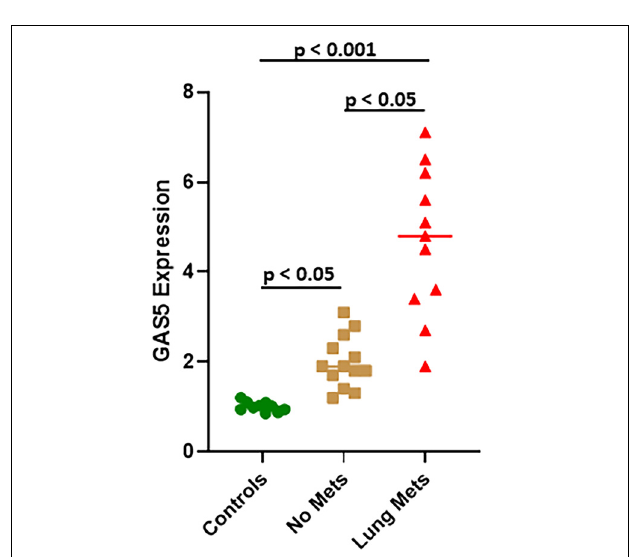
FIGURE 6 | miR-21 in lung metastases of osteosarcoma. Expression of miR-21 was analyzed in osteosarcoma patient samples using quantitative real-time PCR (qRT-PCR). Individual p values are mentioned for the direct comparisons of individual patient